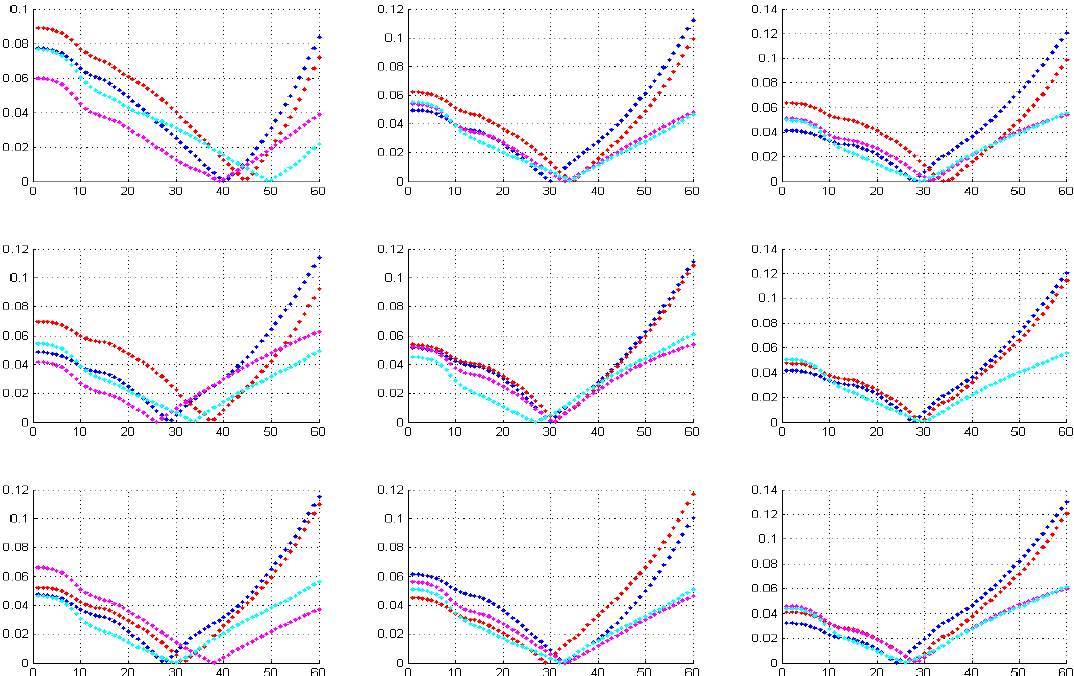
Figure 6. Wind speeds retrieval for a window of a 3 × 3 wind vector cells. X-axes are retrieved wind speeds (m/s), and y-axes are the absolute difference between measured and modeled radar backscatter ( 𝜎 𝑀𝑒𝑎𝑠0 – 𝜎 𝐺𝑀𝐹0 ). Color indicates different σ 0